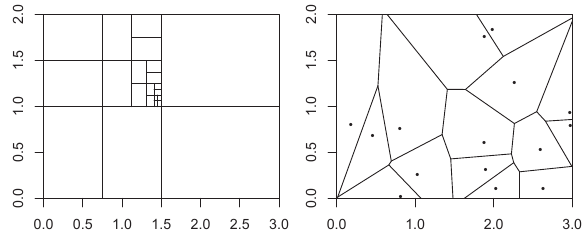
Figure 1: Left: Exemplary partitioning created by the decision boundary partitioning algorithm. Right: Exemplary partition- ing created by vector quantization represented by a Voronoi diagram. Each point represents one of the current